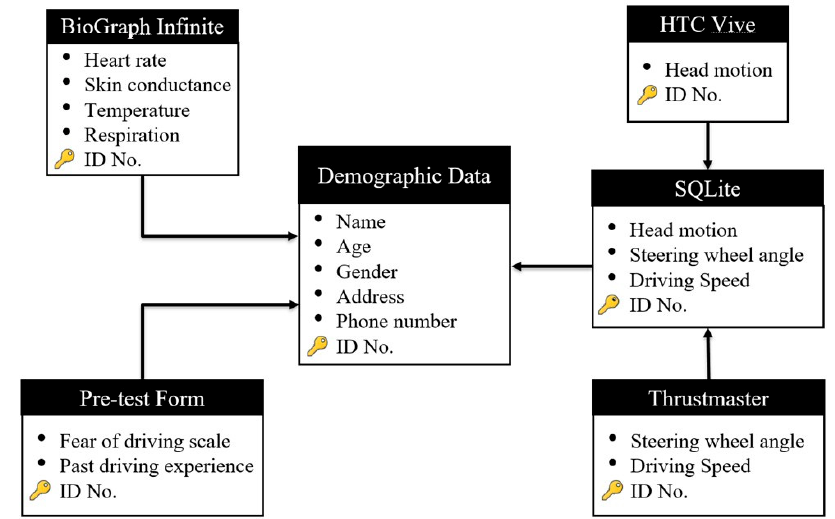
Figure 5. The entity-relation (ER) diagram for the VRET database.